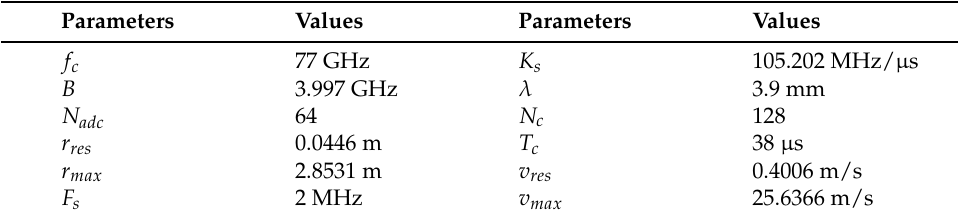
Figure 6. The adopted radar sensor and data collection card. Table 1. Radar configuration